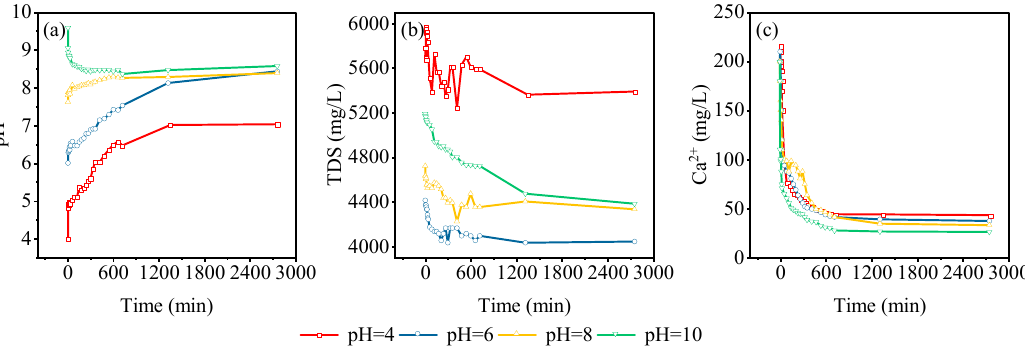
Figure 10. Medium-grained coarse sandstone soaked by mine water at different pH values: ( a ) pH value; ( b ) TDS concentration; ( c ) Ca 2+ concentration.